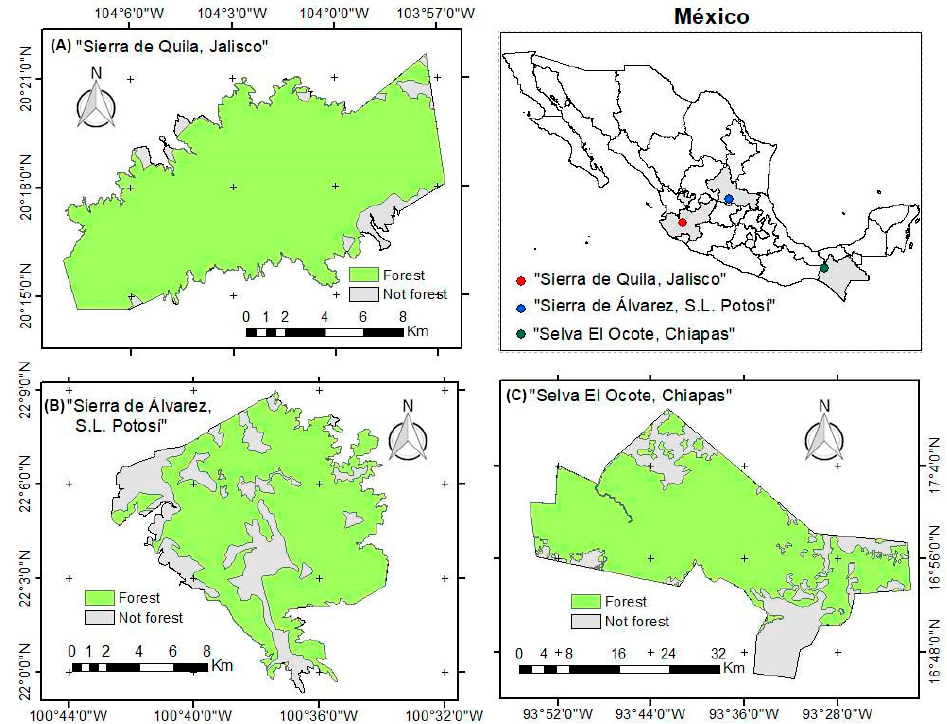
Figure 1. Map showing the locations of study areas: ( A ) “Sierra de Quila, Jalisco”; ( B ) “Sierra de Álvarez, San Luis Potosí,” and ( C ) “Selva El Ocote, Chiapas, México”.